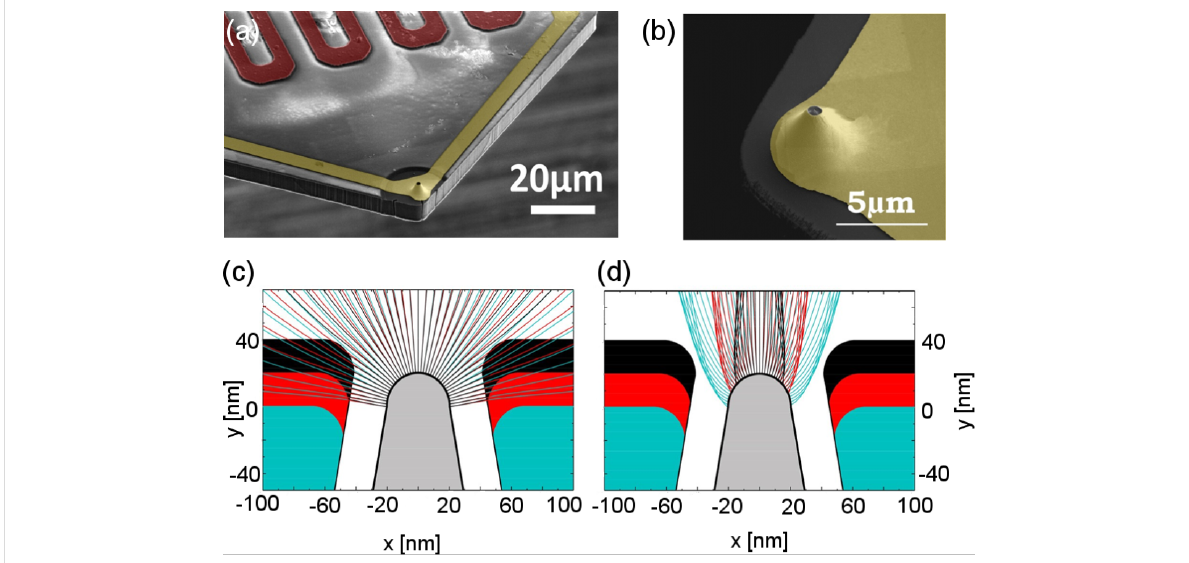
Figure 21: (a, b) SEM images of volcano-gated tip. (c, d) Simulation of the electron beam/trajectories for volcano-gated tips with different volcano heights showing the (c) defocusing and (d) focusing effects. Reproduced with permission from [175], copyright 2017 Elsevier.